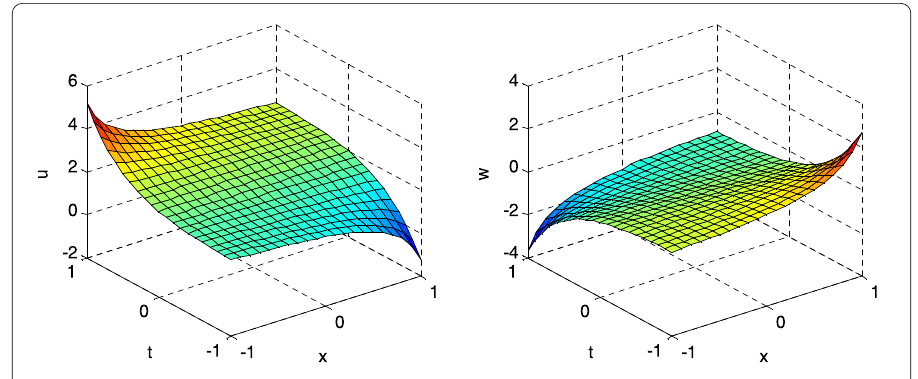
Figure 3 Kink compacton soliton solutions given by equation (3.40) with a 1 = 1, c 1 = –1, K 4 = –1, A = B = 1, and τ 1 ( t ) = cos ech 2 ( t